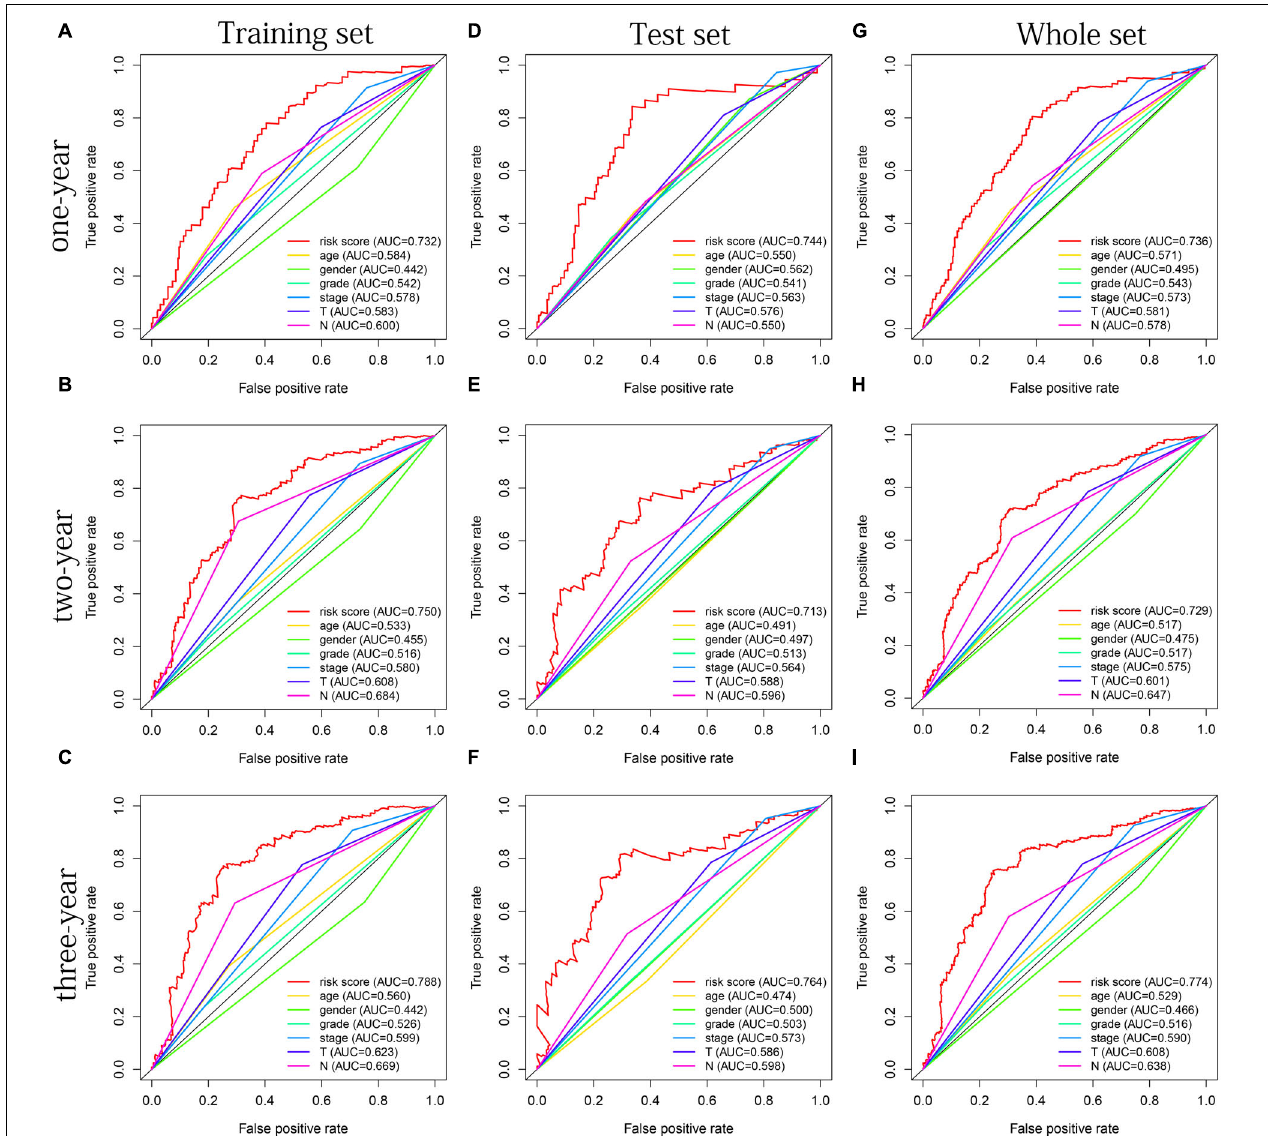
FIGURE 6 | The multifactor ROC curves confirms the best predictive performance of models. (A–C) One, 2, and 3 years of multifactor ROC curves based on training set, respectively. (D–F) One, 2, and 3 years of multifactor ROC curves based on test set, respectively. (G–I) One, 2, and 3 years of multifactor ROC curves based on whole set,